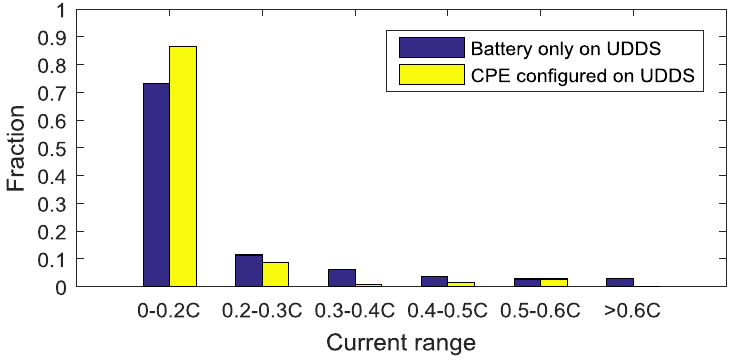
Figure 19. Battery current distribution on UDDS. Energies 2016 , 9 , 903